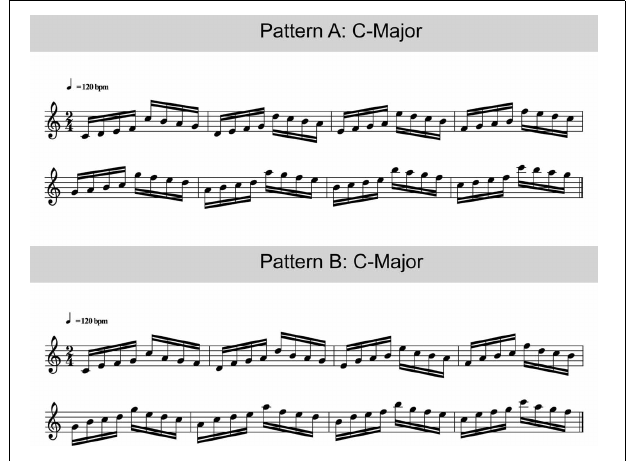
FIGURE 1 | Examples of the stimulus material. Participants were required to perform such sequences with their right hand at an IOI of 125ms, using the fingering 1-2-3-4-5-4-3-2-1-2-3-4-5-4 ... etc. (1, thumb; 2, index finger; 3, middle finger; 4, ring finger; 5, pinkie